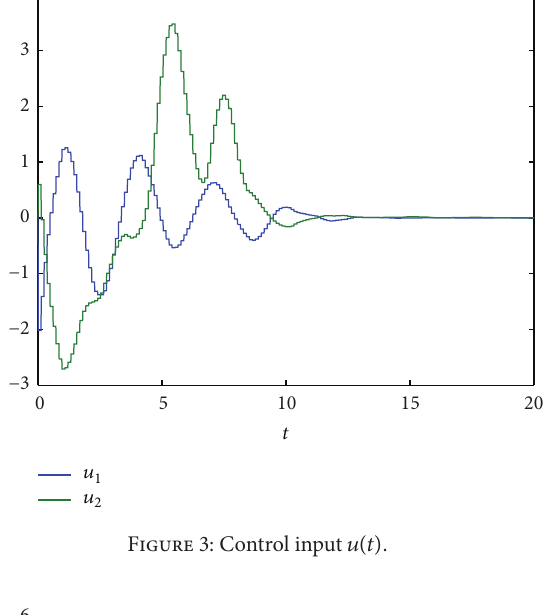
Figure 3: Control input 𝑢(𝑡) .